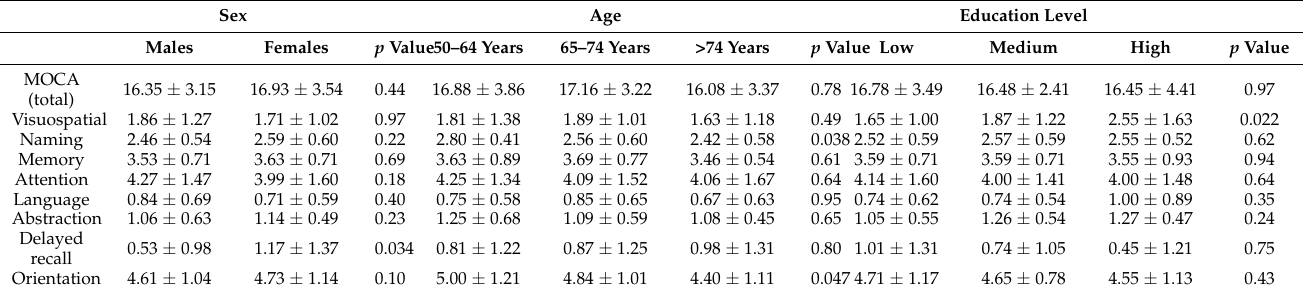
Table 5. Effects of characteristics of subjects on MoCA total score and its sub-domains in demented